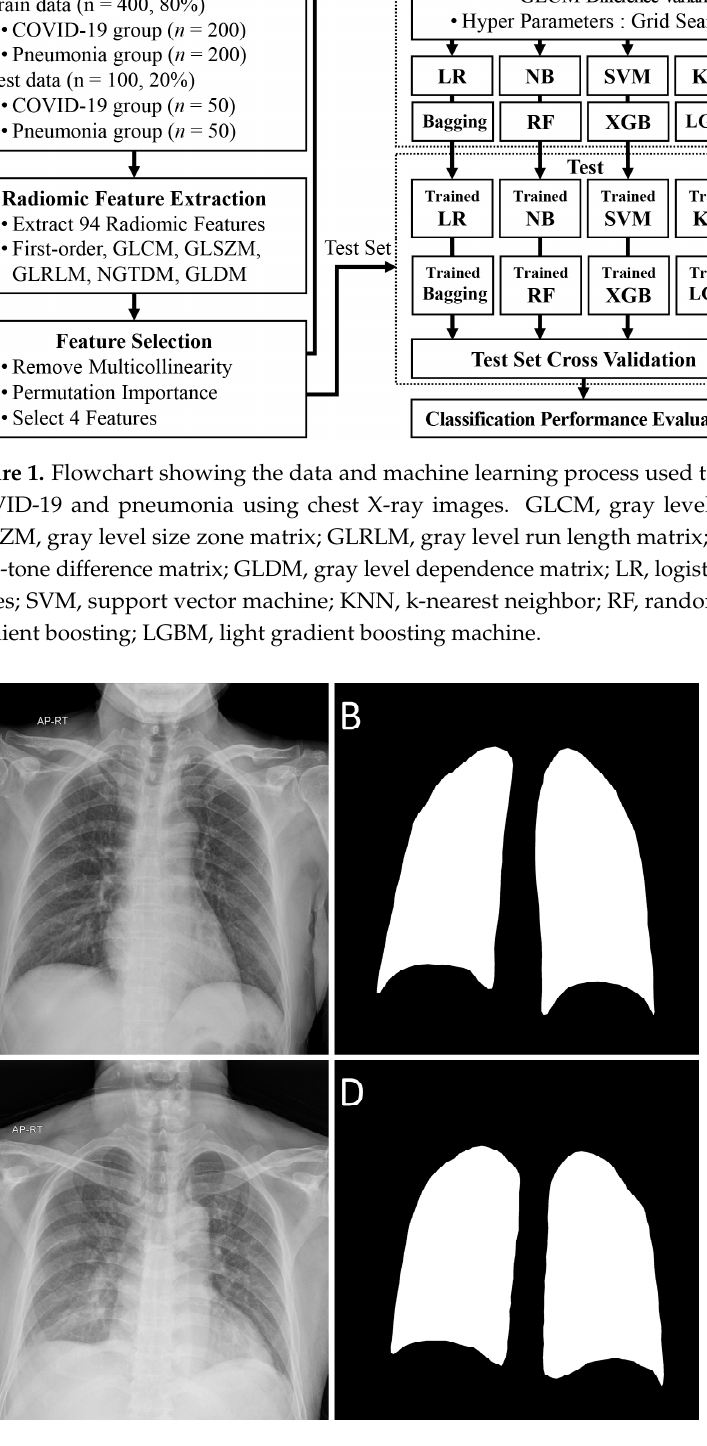
Figure 2. Chest X-rays and ROIs for lungs collected for COVID-19 and pneumonia. ( A ) COVID-19 image, ( B ) ROI mask image from COVID-19 image, ( C ) pneumonia image, and ( D ) ROI mask image from pneumonia image. ROI, region of interest.